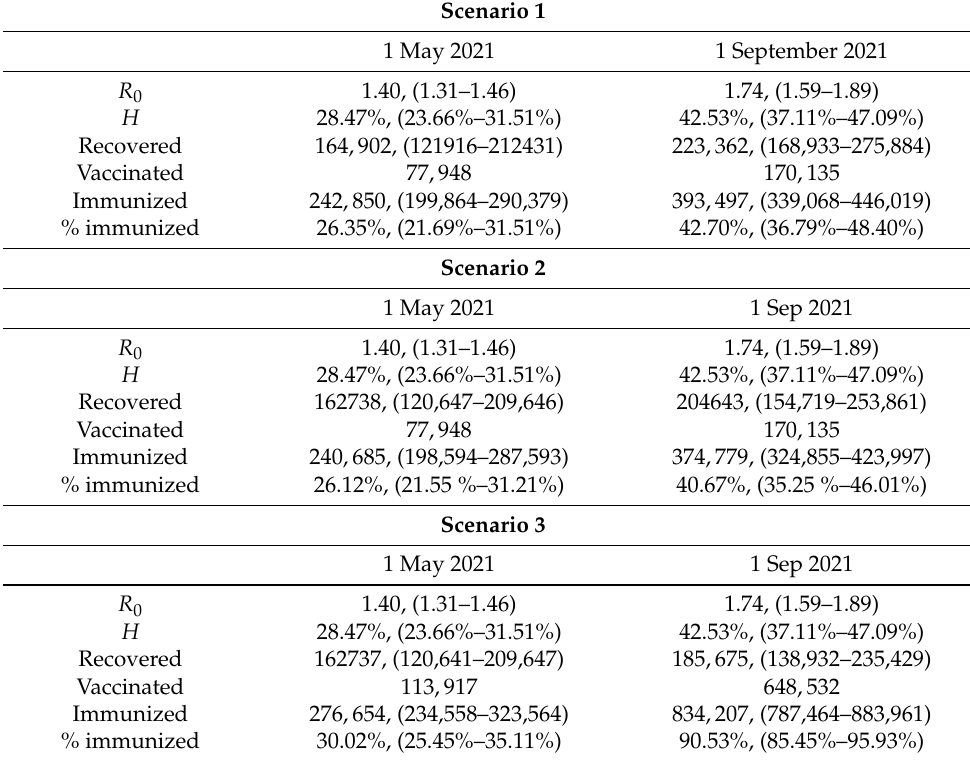
Table 4. Comparison between the required percentage to reach the herd immunity ( H ) with the percentage of immunized people the 1 May and the 1 September (% immunized). Observe that the percentage of immunized people is very close to the required in Scenarios 1 and 2, and greater in Scenario 3. This explains why, after 1 May, there is a decline in the number of infected, more significant in scenario 3 where the vaccination pace